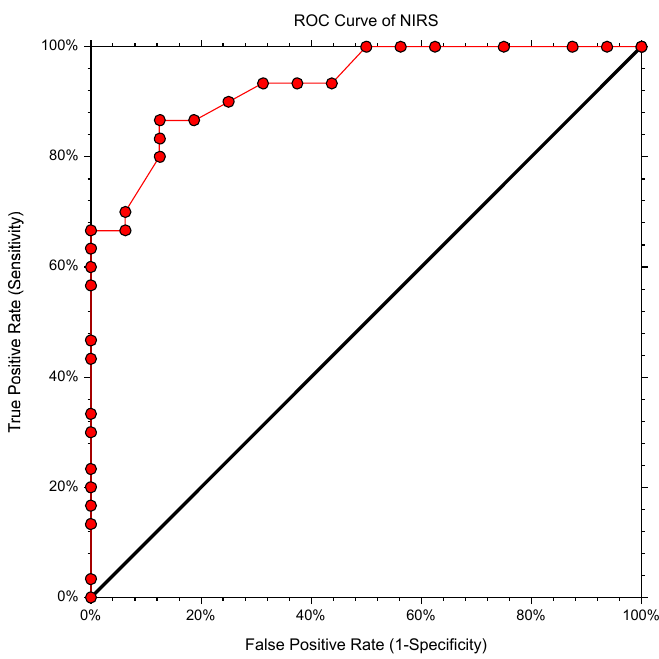
Figure 6. ROC curve analysis of ETCO 2 to predict oximetry changes (NIRS).